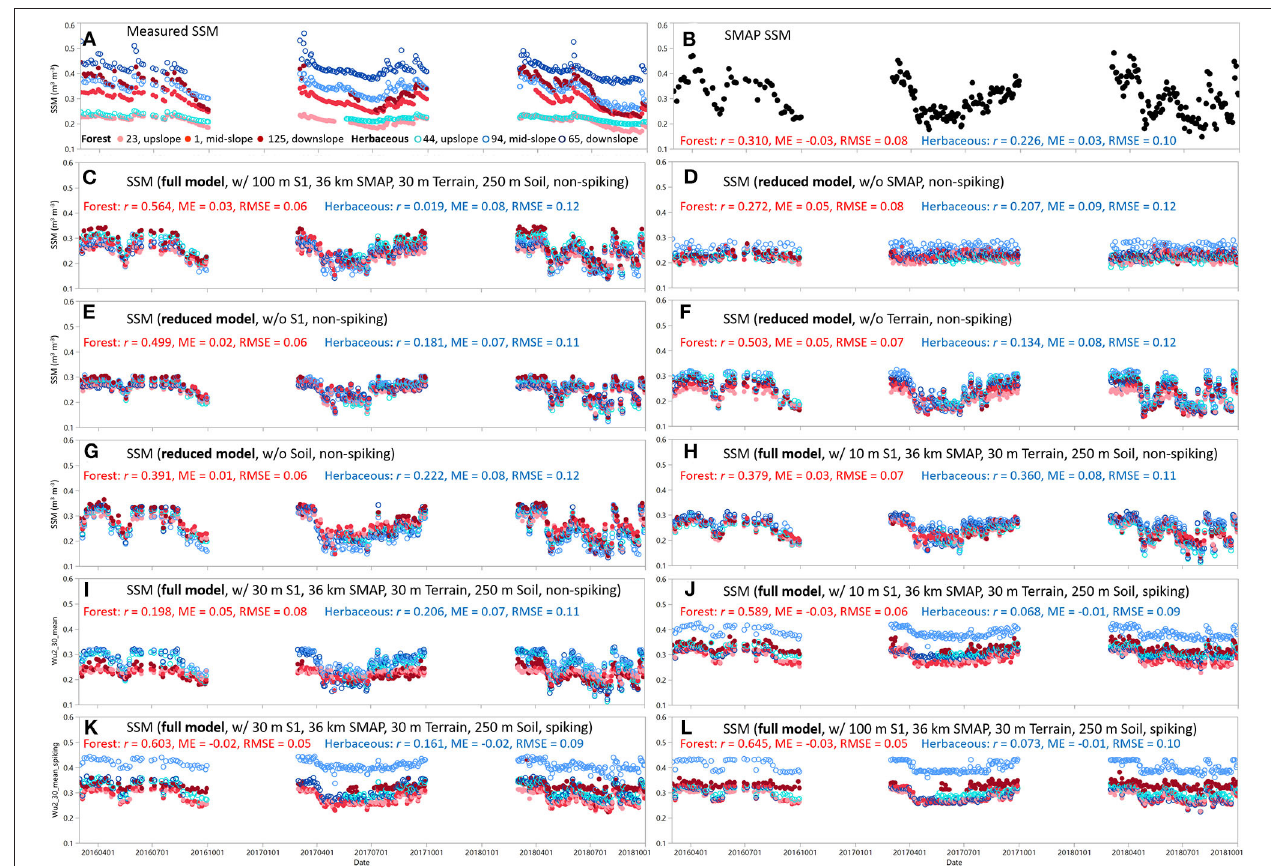
FIGURE 6 | Measured (A) vs. predicted surface soil moisture (SSM, m 3 m − 3 ) from SMAP L3 product (SMAP, B ) and the quantile random forest (QRF) models at selected stations of the field-scale soil moisture network (TERENO-Wüstebach). The QRF models were first established without local training datasets using different input covariates including full model with Sentinel-1 aggregated at 100m (C) and the corresponding reduced models by dropping SMAP (D) , Sentinel-1 (E) , terrain parameters (F) , or soil properties (G) , and full models with Sentinel-1 aggregated at 10m (H) and 30m (I) . QRF models were also established by including 10% local training stations with different resolutions of Sentinel-1 data at 10m (J) , 30m (K) , and 100m (L) . R2, coefficient of determination; ME, mean error; RMSE, root mean squared error. Validation stations under forest: 23 (upslope), 1 (mid-slope) and 125 (downslope); validation stations under herbaceous: 44 (upslope), 94 (mid-slope), and 65